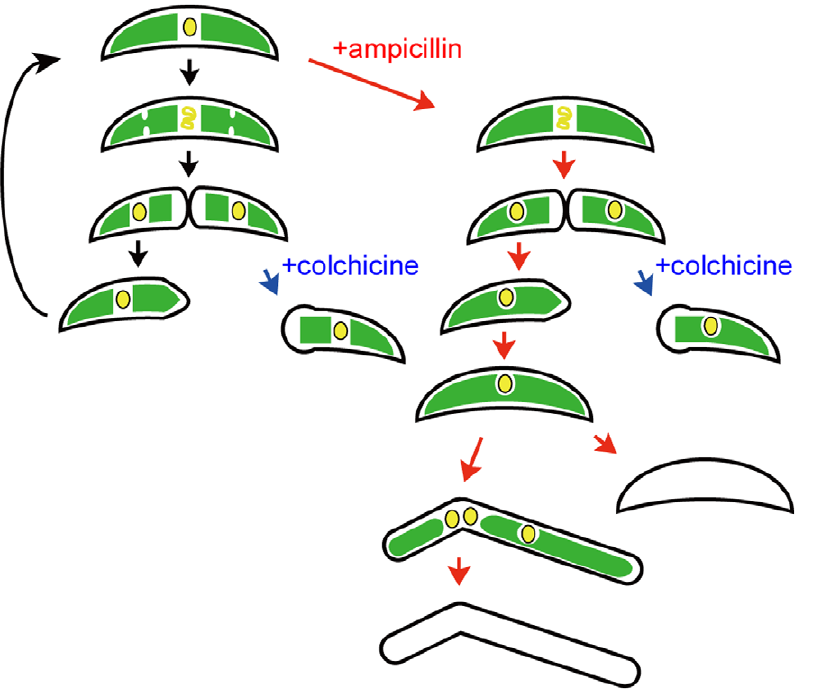
Figure 6. Morphological changes in Closterium cells treated with antibiotics. Without ampicillin (left panel), each of two chloroplasts divides before septum formation. After cell division, the daughter cell restores the crescent-shaped morphology with expansion of the new semicell. Colchicine inhibits elongation of the new semicells at 2 mM. With ampicillin (right panel), cells divide without chloroplast division to form semicells with only one chloroplast. Because cells can elongate without colchicine, crescent-shaped cells with only one chloroplast form. Then, long cells with several nuclei appear due to inhibition of cell division. During a long cultivation, cells die off.